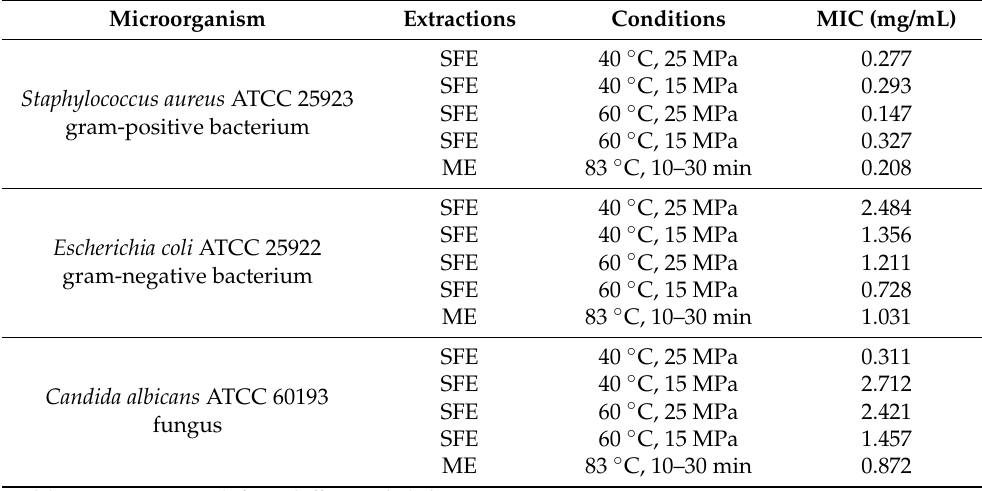
Table 1. Determination of the MIC by the resazurin dye microdilution method for five different extracts against two standard bacteria and one fungus. Microorganism